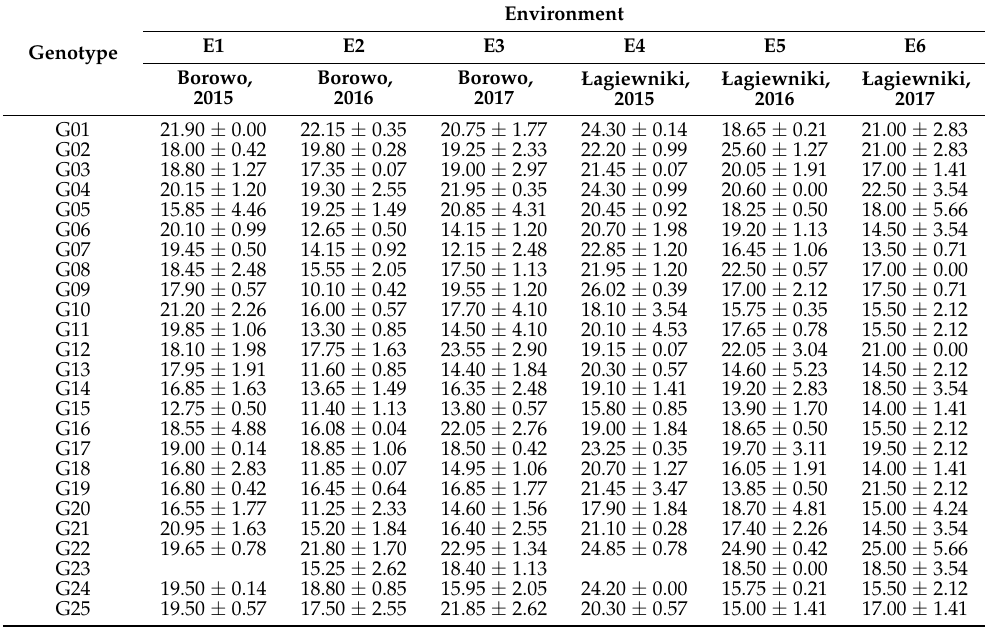
Table 11. Mean values ± standard deviations (s.d.) for the number of seeds per silique of winter oilseed rape genotypes in particular